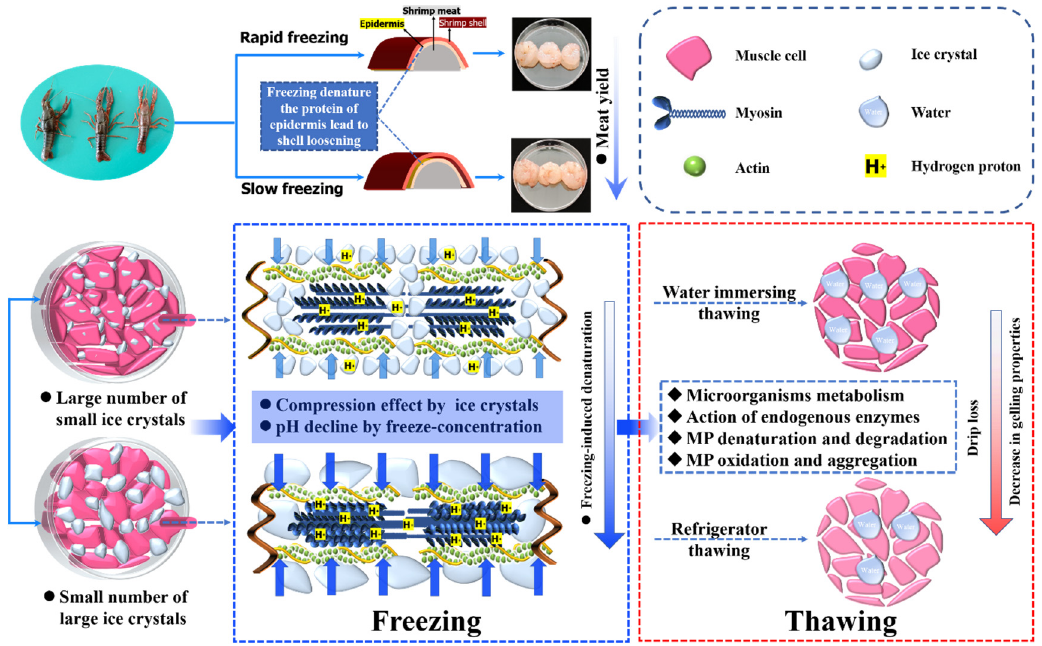
Figure 7. The schematic diagram of the effect of freeze-thawing on crayfish meat and its gelling properties.